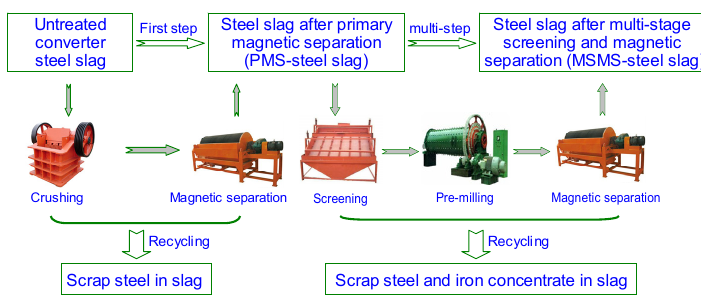
Figure 5. The technical flow process of recycling iron ‐ rich phases in steel slag.